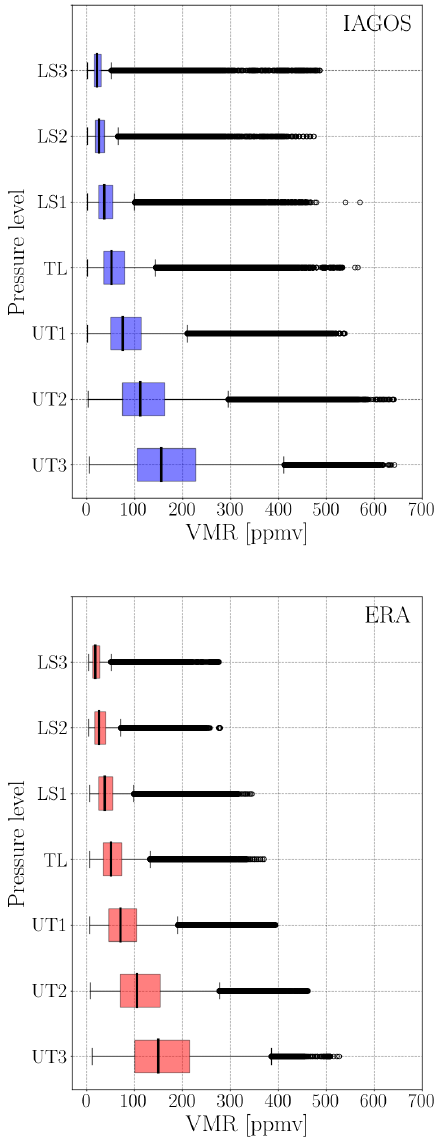
Figure 2. Vertical profile of temperature (K) for IAGOS (blue) and ERA (red).